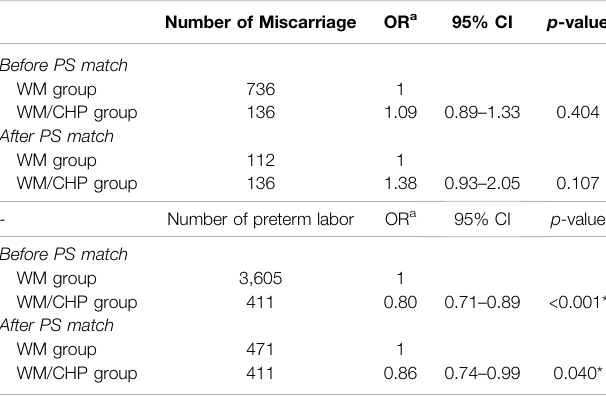
TABLE 2 | Odd ratio estimates for birth outcome (preterm labor or miscarriage) of pregnant women between WM and WM/CHP groups. Number of Miscarriage OR a 95%